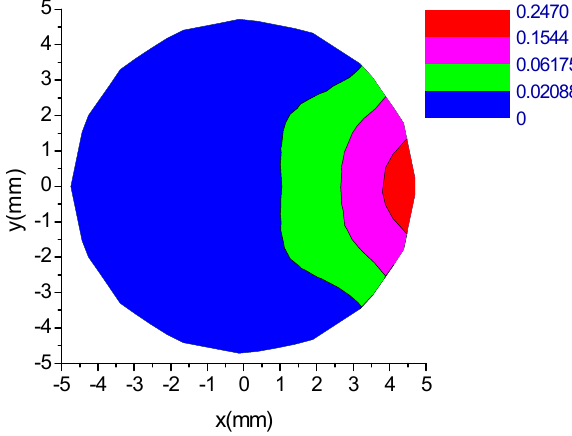
Figure 3. Sensitivity field of an electrode over the central cross section ( z = 0) [12].